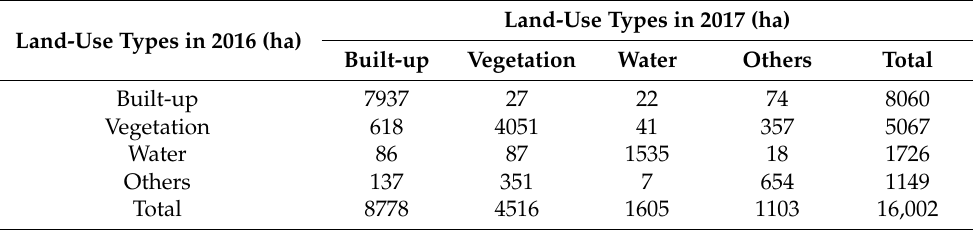
Table 6. Transformation among land use types from years 2016 and 2017 in inner Hanoi. Land-Use Types in 2016